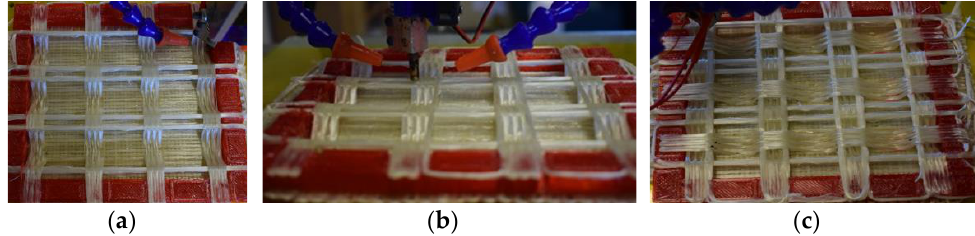
Figure 12. ( a ) Composite Truss Segments in ‘ 2 ’ Direction, ( b ) Composite Scaffolding in ‘ 2 ’ Direction, ( c ) Completed Navtruss core prior to addition of the top facesheet.